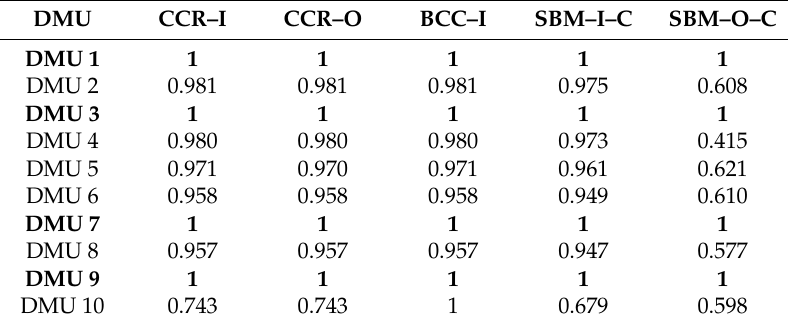
Table 7. Results of the DEA